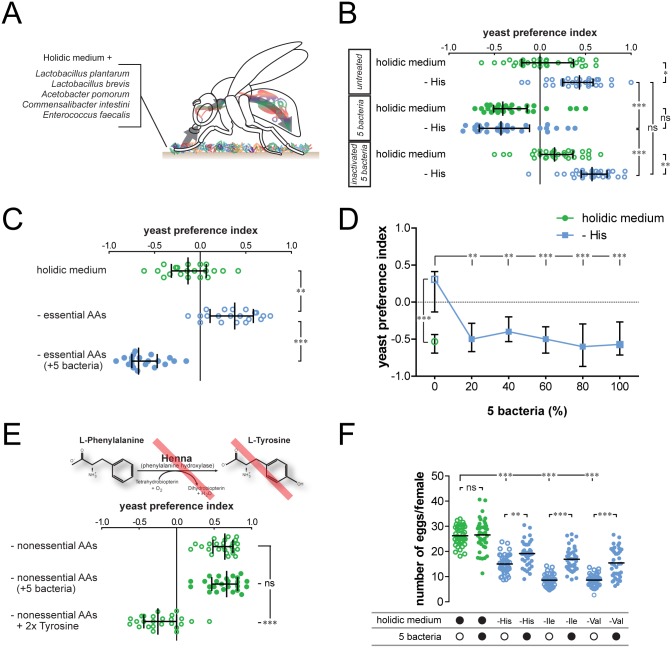
Commensal bacteria control food choice and egg laying.(A) Diagram depicting the strategy used to reconstitute the commensal population in the fly. (B) Yeast preference of animals kept on holidic diet with or without histidine (His). One group was not pretreated with the five commensals (untreated), the other was pretreated with the commensals (five bacteria), and the third was pretreated with inactivated commensals (inactivated five bacteria). (C) Yeast preference of animals kept on holidic diet, holidic diet without essential amino acids (eAAs), or holidic diet without eAAs pretreated with the commensal mix. (D) Yeast preference of animals kept on holidic diet with or without His and pretreated with varying concentrations of the commensal mix. (E) Yeast preference of Henna knockdown animals (tubulin > HennaIR1) kept on holidic diet lacking nonessential amino acids (neAAs), with or without pretreatment with the commensal mix, and holidic diet lacking neAAs with 2x tyrosine (Tyr) added back. (F) Number of eggs laid per female in 24 h of animals kept on holidic diet, holidic diet with all amino acids except His, isoleucine (Ile), or valine (Val), and with or without pretreatment with commensals. Black filled circles represent complete holidic medium or pretreatment with the bacteria mix. Open black circles represent flies that were not pretreated with bacteria mix. Amino acid (AA) deprivation is indicated as –His, –Ile or –Val. Data are pooled from two different rounds of experiments performed independently on different days. n = 39–40. (B, C, and E) Circles represent yeast preference in single assays, with a line representing the median and whiskers representing the interquartile range. Filled circles represent assays in which flies had been pretreated with commensals. n = 20–30. (D) Points represent median yeast preference and error bars represent the interquartile range. n = 15. (F) Circles represent eggs laid in single assays, with the line representing the mean. (B–E) Significance was tested using the Kruskal–Wallis test followed by Dunn’s multiple comparison test and in (F) using the one-way analysis of variance test followed by Bonferroni’s multiple comparison test (B–F) Not significant (ns) p > 0.05, * p < 0.05, ** p < 0.01, *** p < 0.001. Underlying data used in this Fig are provided in S1 Data.